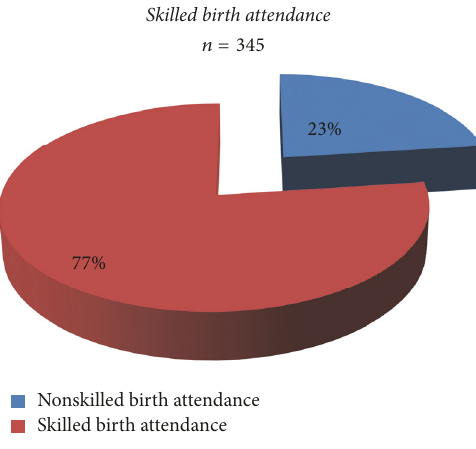
Figure 1: Skilled birth